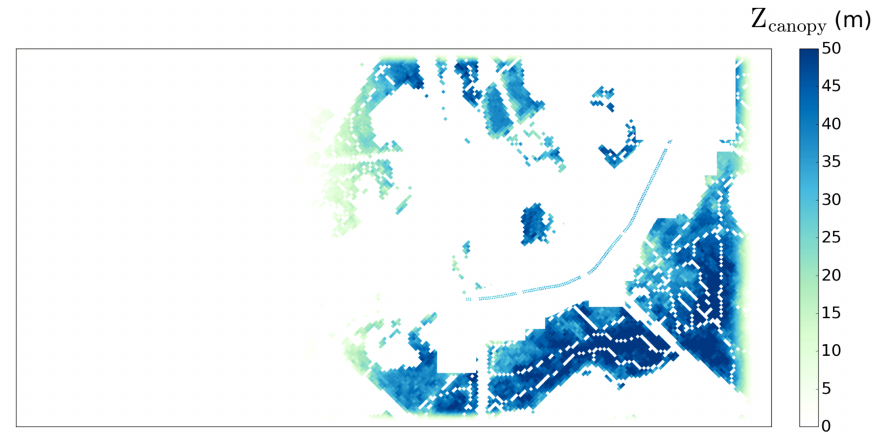
Figure 3. A map of the tree canopy height Z canopy (m) for the whole computational domain. Orientation as in Figure